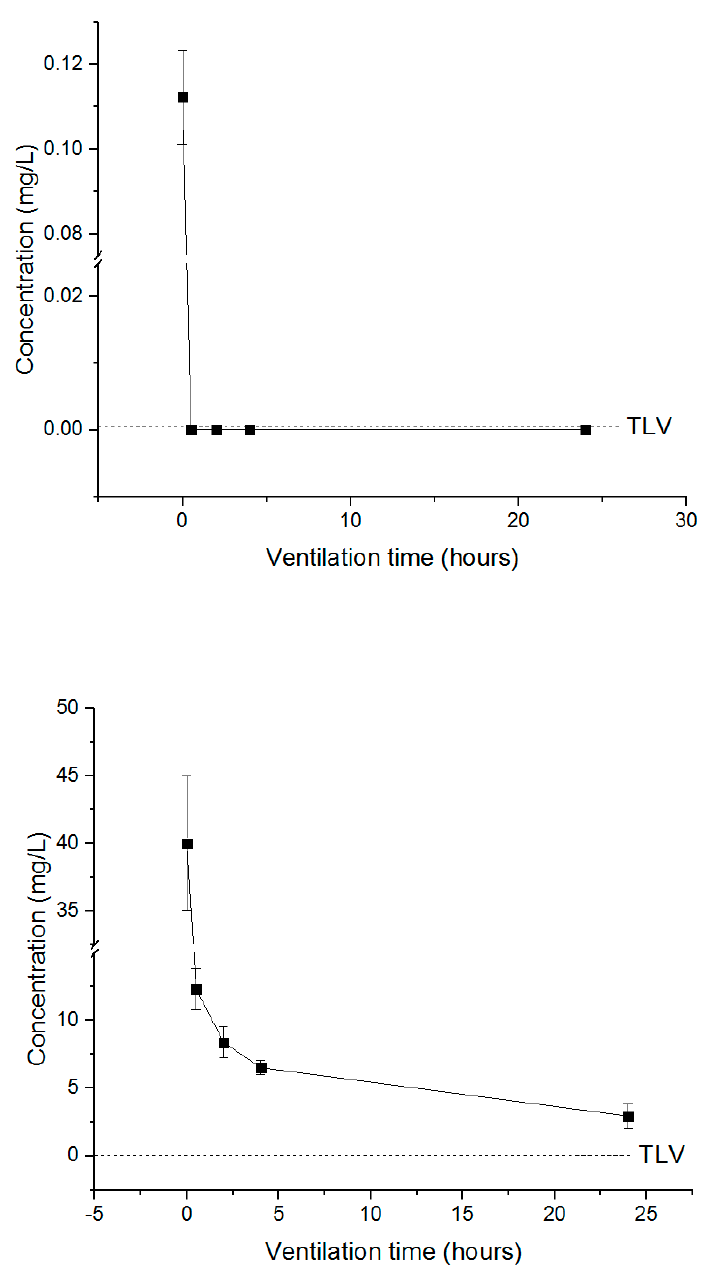
Figure 9. The concentration of PH 3 + EF inside the desiccator under resealed conditions. Each value represents the mean ± SE ( n = 3).